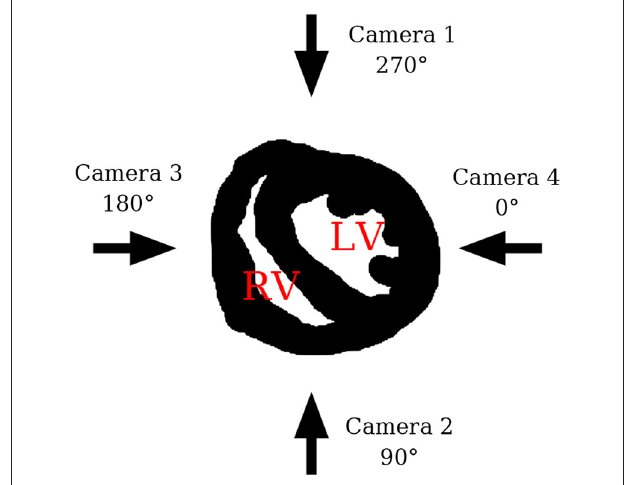
FIGURE 4 | Sketch showing the four different camera perspectives in relation to the heart. LV indicates the position of the left ventricle and RV the position of the right ventricle.